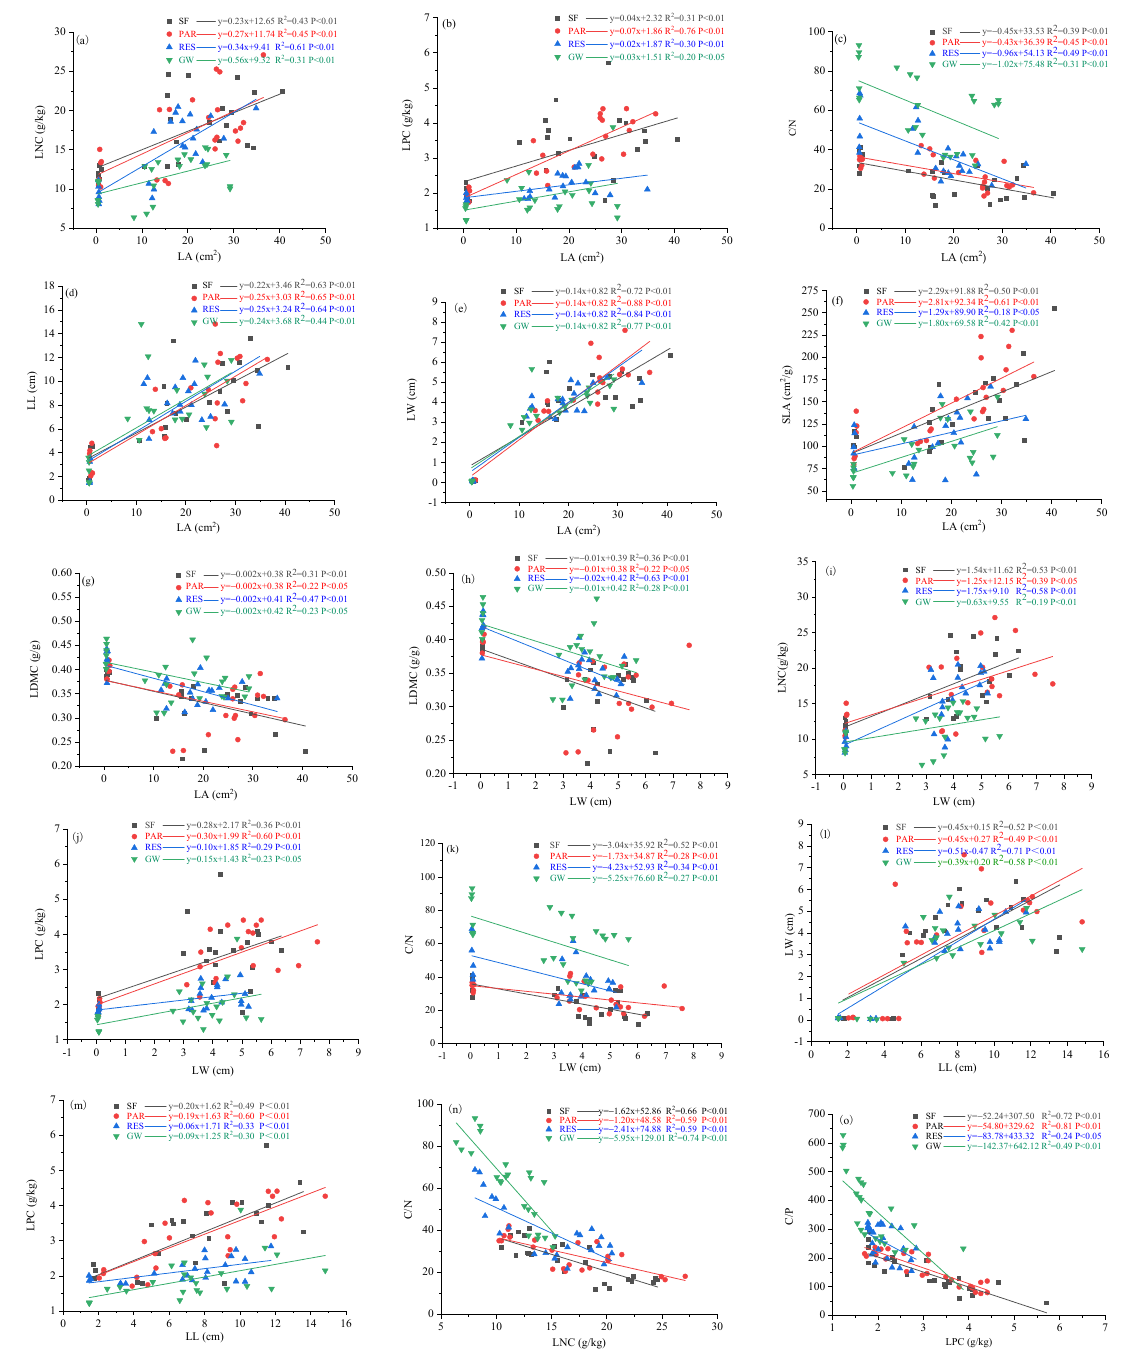
Figure 5. Linear regression between leaf traits with significant correction ( p < 0.05 or p < 0.01) on plants among four green space environments. SF = sport field; PAR = park; RES = residential green space; GW = greenway. LA = leaf area; LL= leaf length; LW = leaf width; SLA = specific leaf area; LDMC = leaf dry matter content; LCC = leaf carbon content; LNC = leaf nitrogen content; LPC = leaf phosphorus content; C/N = leaf carbon/nitrogen ratio; C/P = leaf carbon/phosphorus ratio; N/P = leaf nitrogen/phosphorus ratio. ( a ) LNC and LA; ( b ) LPC and LA; ( c ) C/N and LA; ( d ) LL and LA; ( e ) LW and LA; ( f ) SLA and LA; ( g ) LDMC and LA; ( h ) LDMC and LW; ( i ) LNC and LW; ( j ) LPC and LW; ( k ) C/N and LW; ( l ) LW and LL; ( m ) LPC and LL; ( n ) C/N and LNC; ( o ) C/P and